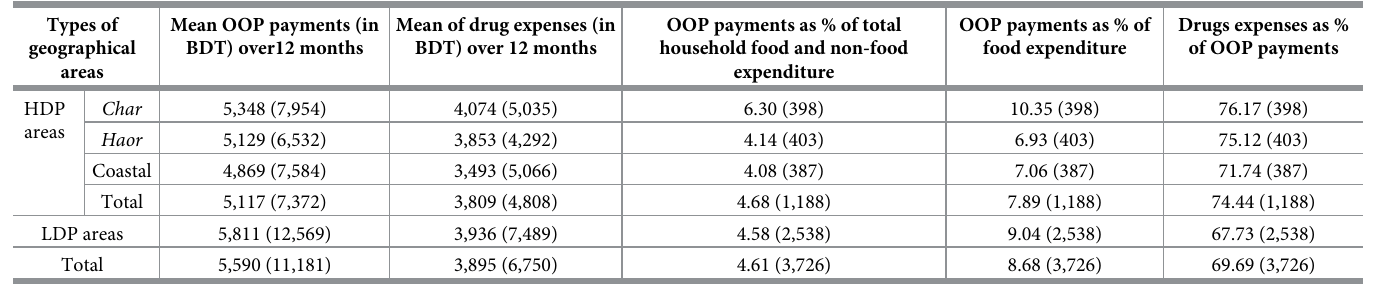
Table 2. Out-of-pocket payments per affected household by the geographical areas. Types of geographical